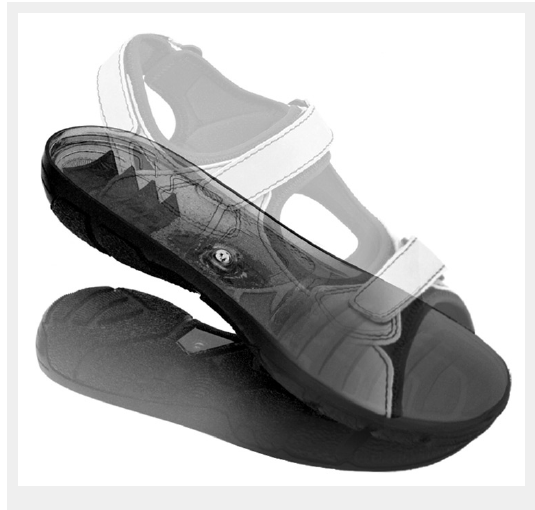
The unstable Biodyn sandal with a regular shaped shoe